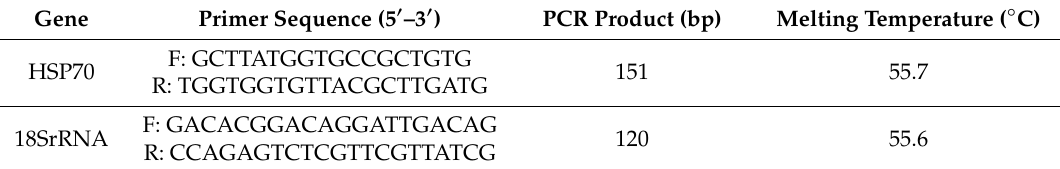
Table 2. Primer sequences used for real-time PCR of HSP70 gene in the